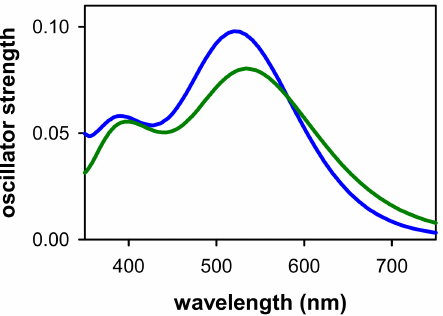
Figure 4. Absorption spectra computed for the optimized radical cation in (G 4 A) 4 /K + (green) and (AG 4 ) 4 /K + (cyan) at the PCM/TD-DFT(M052X)/6-31G(d)//MM level of